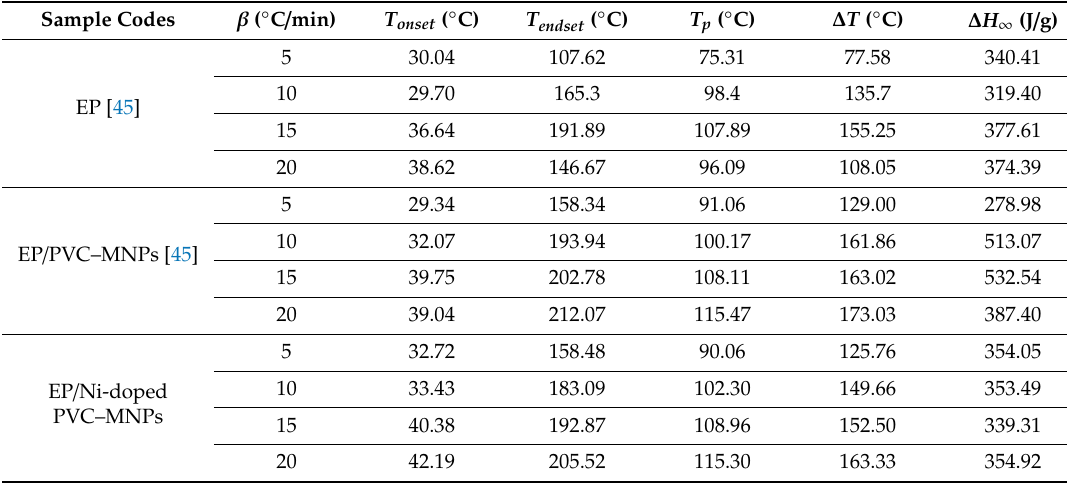
Table 1. Cure parameters of the neat epoxy and its nanocomposites in terms of the rate of heating applied in nonisothermal DSC analyses. The neat epoxy and the epoxy containing PVC–MNPs were used as the control systems studied recently.